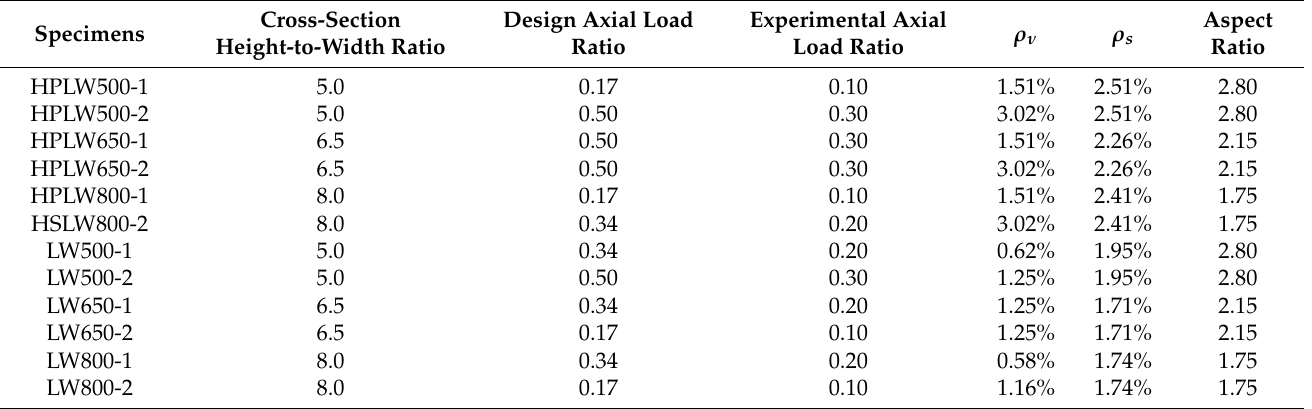
Table 1. Parameters of HPLW and LW.